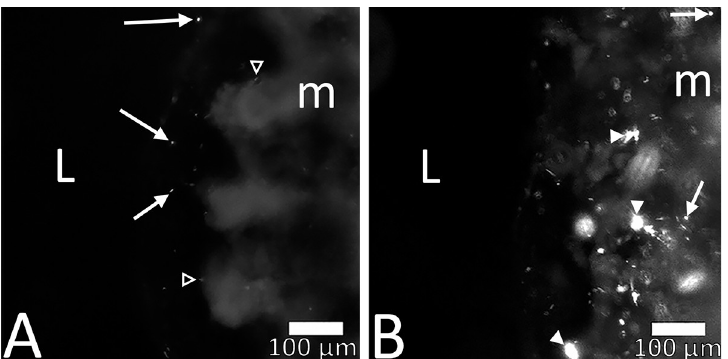
Fig 3. S . ser . Typhimurium- GFP infiltrated colon mucosa within 24 h of culture. At 4 h ex vivo (A) S . ser . Typhimurium- GFP were seen approaching the luminal aspect of the colonic mucosa (arrows) with minimal mucosal binding observed (open arrow heads in A). S . ser . Typhimurium-GFP appeared in colonic mucosa at 24 h post inoculation (B), and were often clustered together (arrowheads in B). Scale bar in both panels is 100 μ